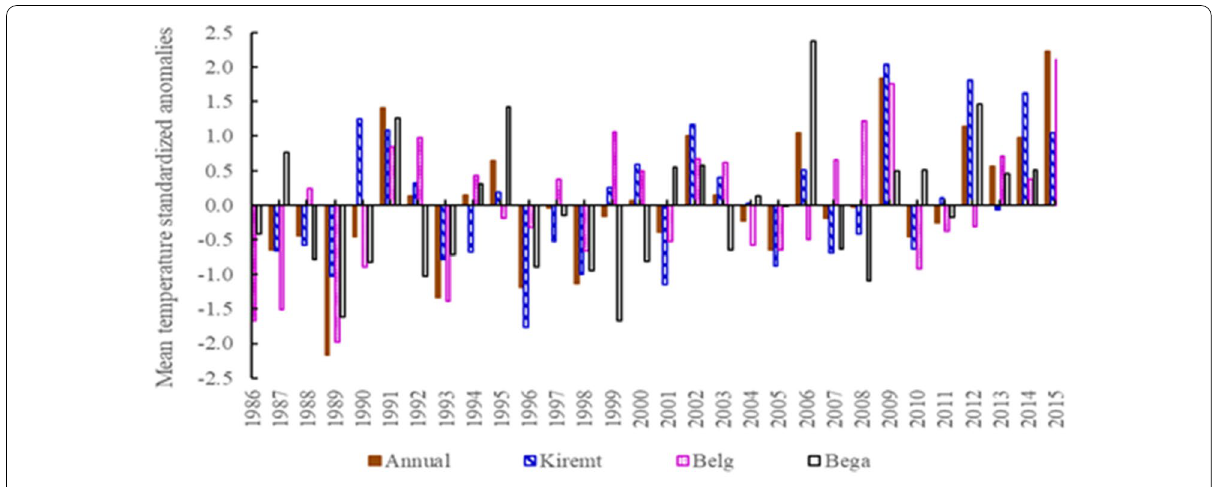
Fig. 4 Mean annual and seasonal Tmean standardized anomalies